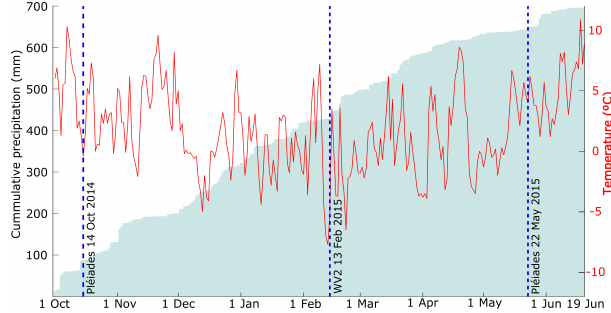
Figure 5. Cumulative precipitation (clear blue) and tempera- ture (red line) for the winter 2014–2015 (1 October 2014 to 19 June 2015) from the station Litla Ávík. Blue dashed lines show the time of acquisition of satellite stereo